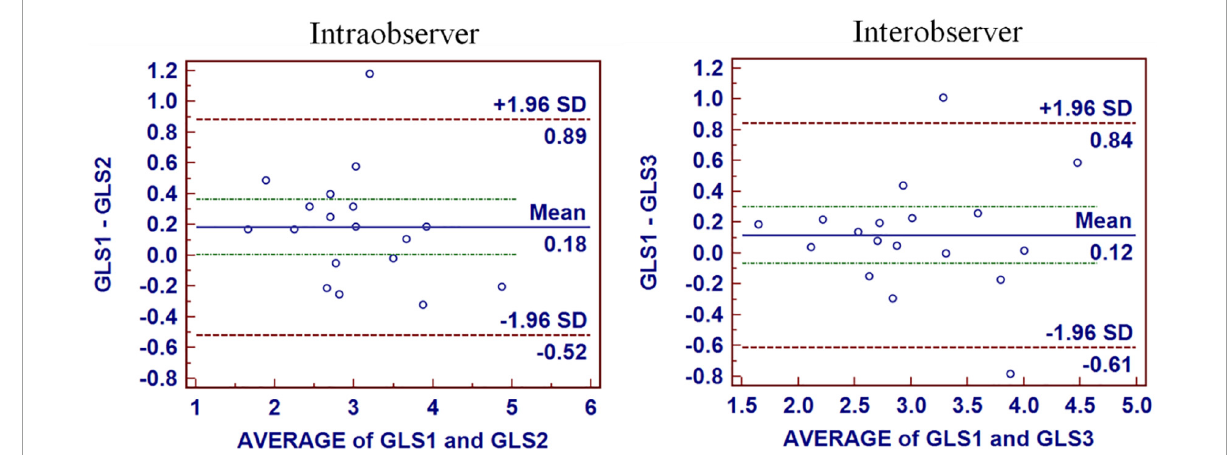
FIGURE3 Intraobserver and interobserver reproducibility for GLS. The mean bias of intraobserver was 0.18 (limits of agreement, − 0.52 to 0.89) for GLS. The mean bias of interobserver was 0.12 (limits of agreement, − 0.61 to 0.84) for